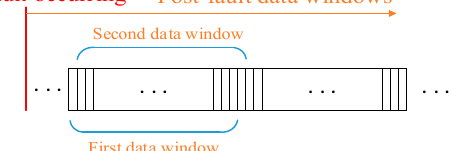
Figure 2. The mode of constructing data window.